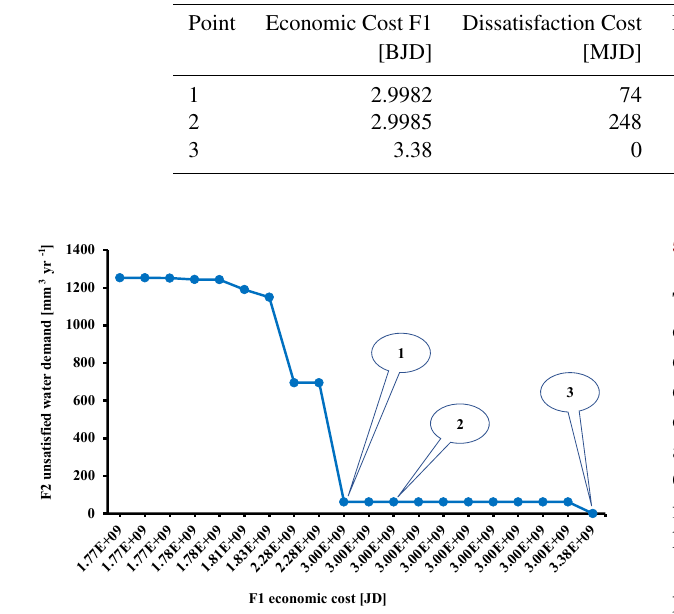
Figure 1. Pareto optimal